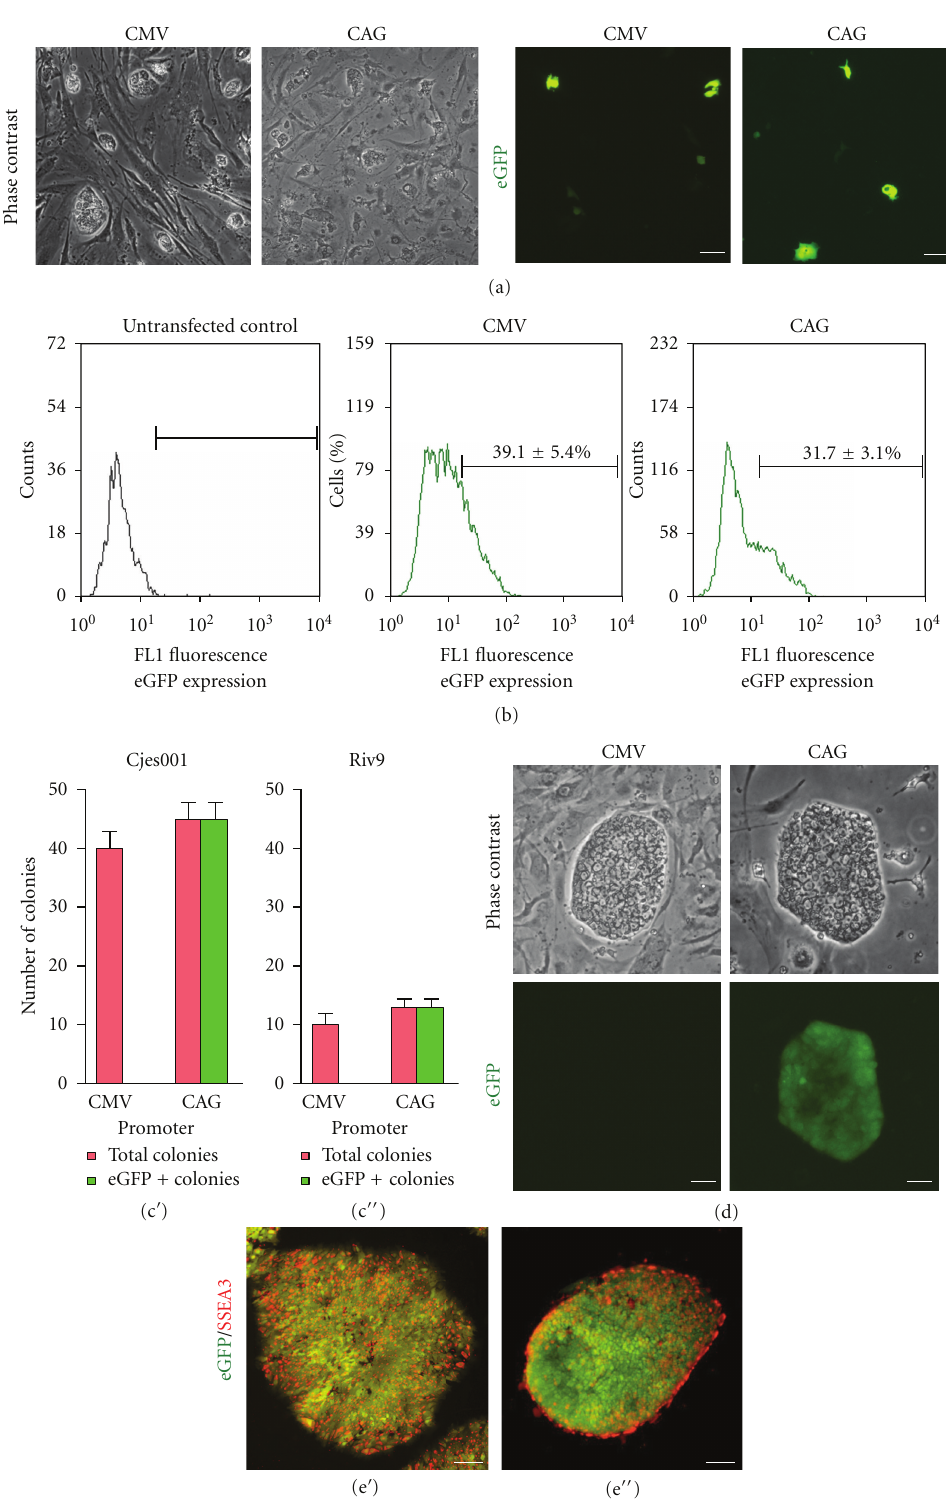
Figure 2: Transfection of cjes001 common marmoset CESCs and Riv9 HIPSCs. Micrographs (a) and FACS histograms (b) enumerating the percentage of eGFP-positive (eGFP +ve) cjes001 CESCs 24 hours after-transfection. (c) Numbers of drug-resistant and eGFP-expressing colonies formed after two weeks were scored for the stable transfection assay. (d) eGFP expression was lost in all pCMV-transfected clones. In contrast, all puromycin-resistant colonies were also eGFP +ve. Cjes001 (e (cid:3) ) and Riv9 clone (e (cid:3)(cid:3) ) retained ubiquitous and constitutive eGFP expression while continuously express undi ff erentiated stem cell marker SSEA3 (red). Scale bars, 50 μ